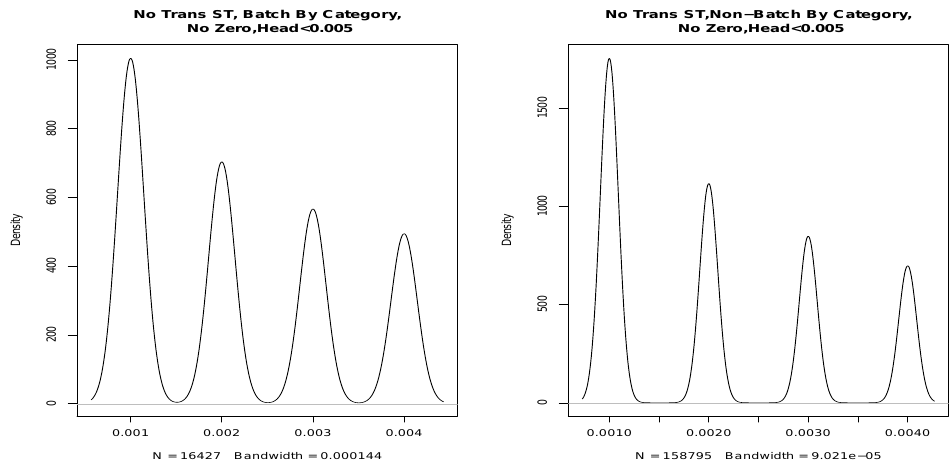
Figure 24. Probability density batch and non-batch by